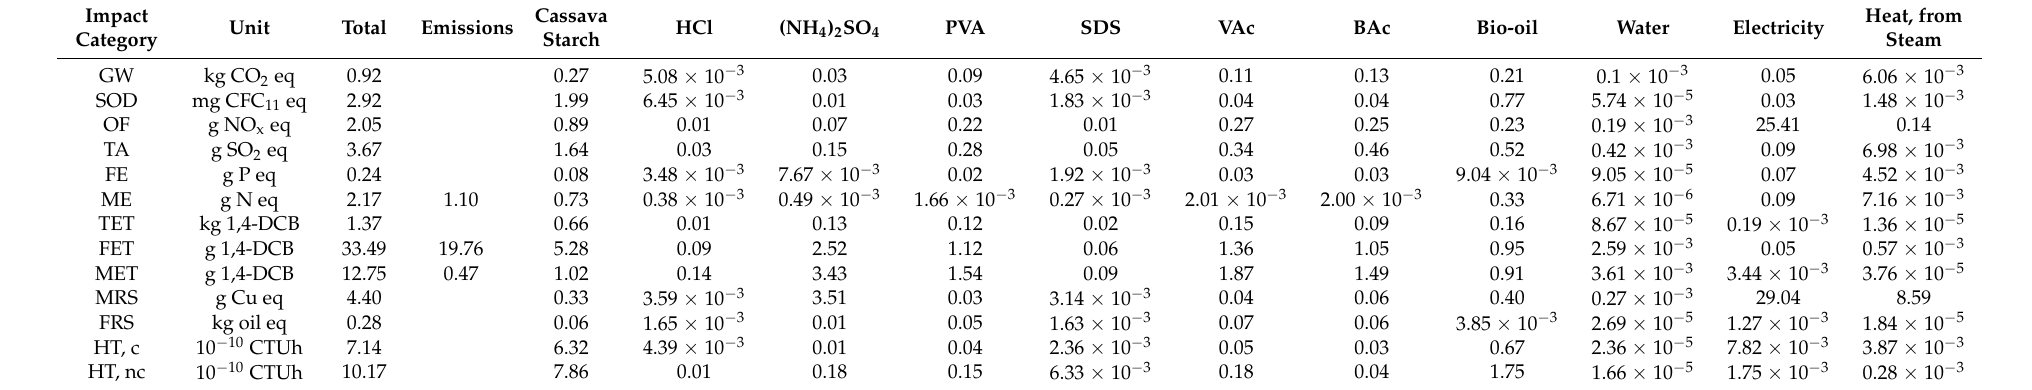
Table 6. Environmental characterization of hydrolyzed starch bioadhesive with bio-oil.